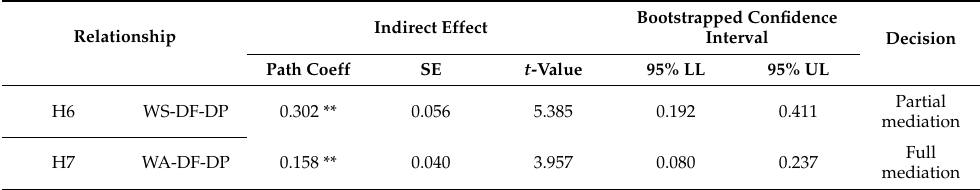
Table 6. Analysis of